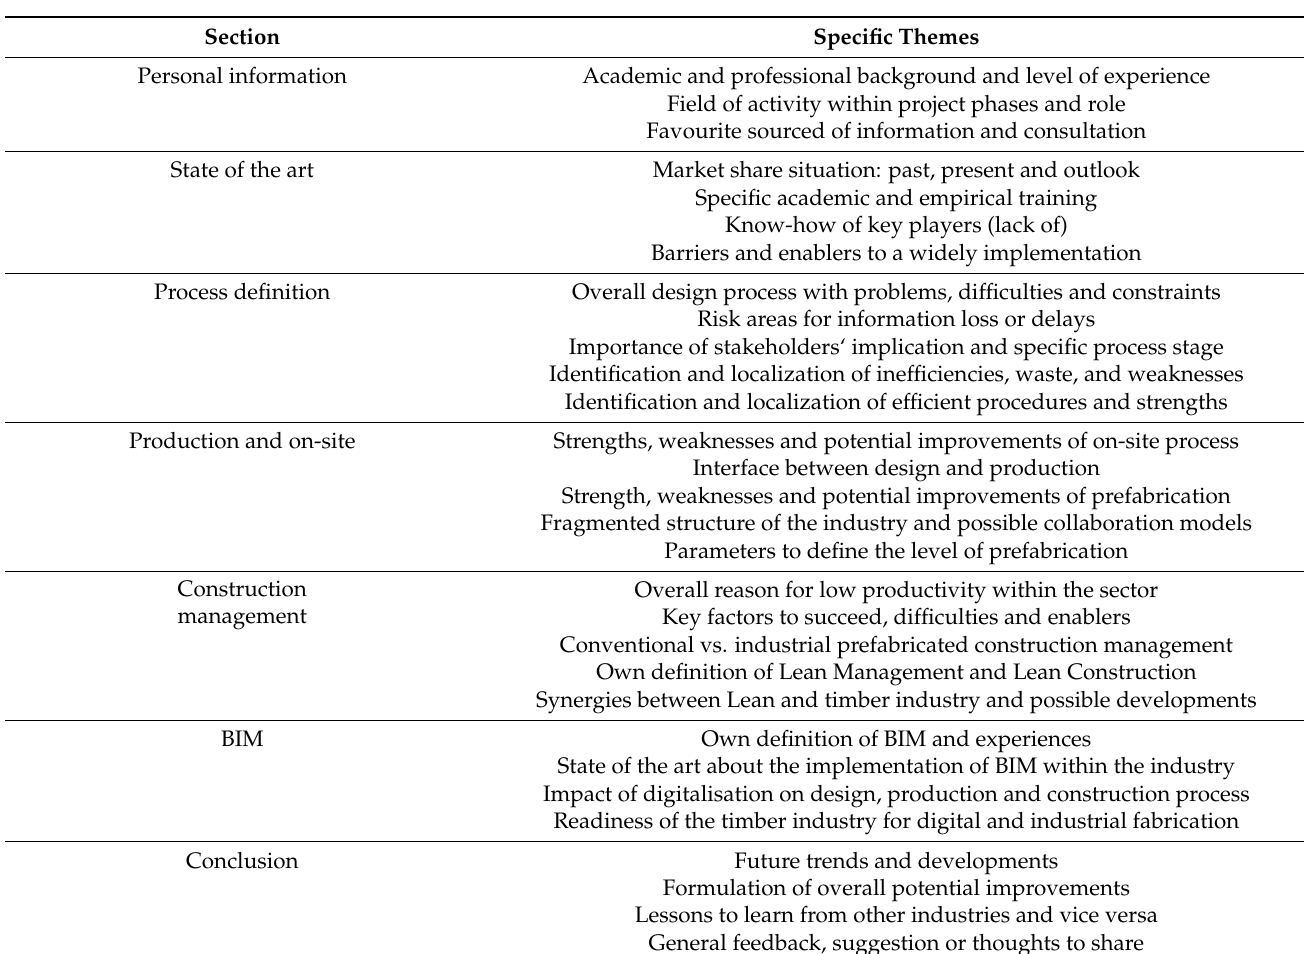
Table 1. Structure of the interview